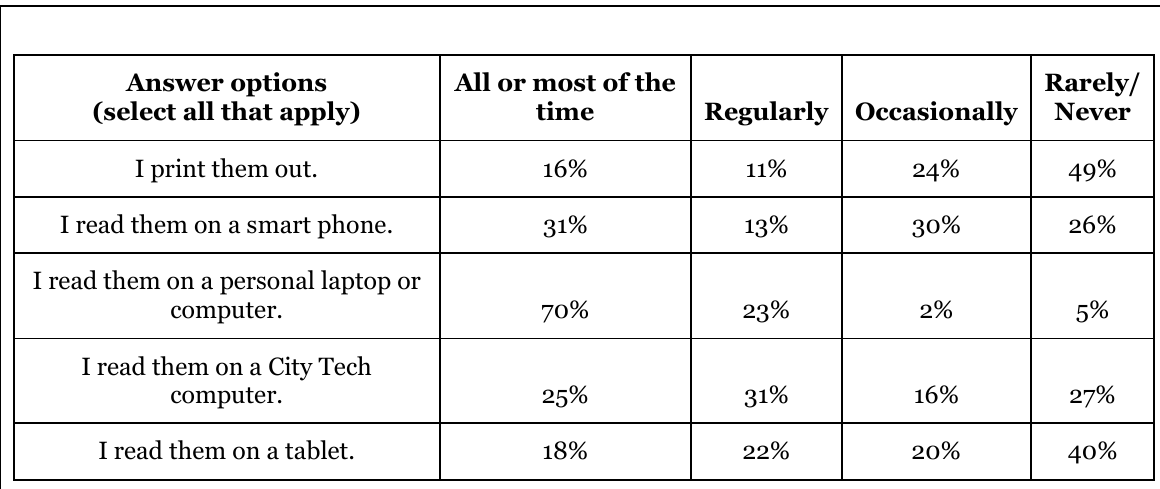
Distribution of Student Responses Regarding How They Access the Assigned Readings From the Health Psychology OER